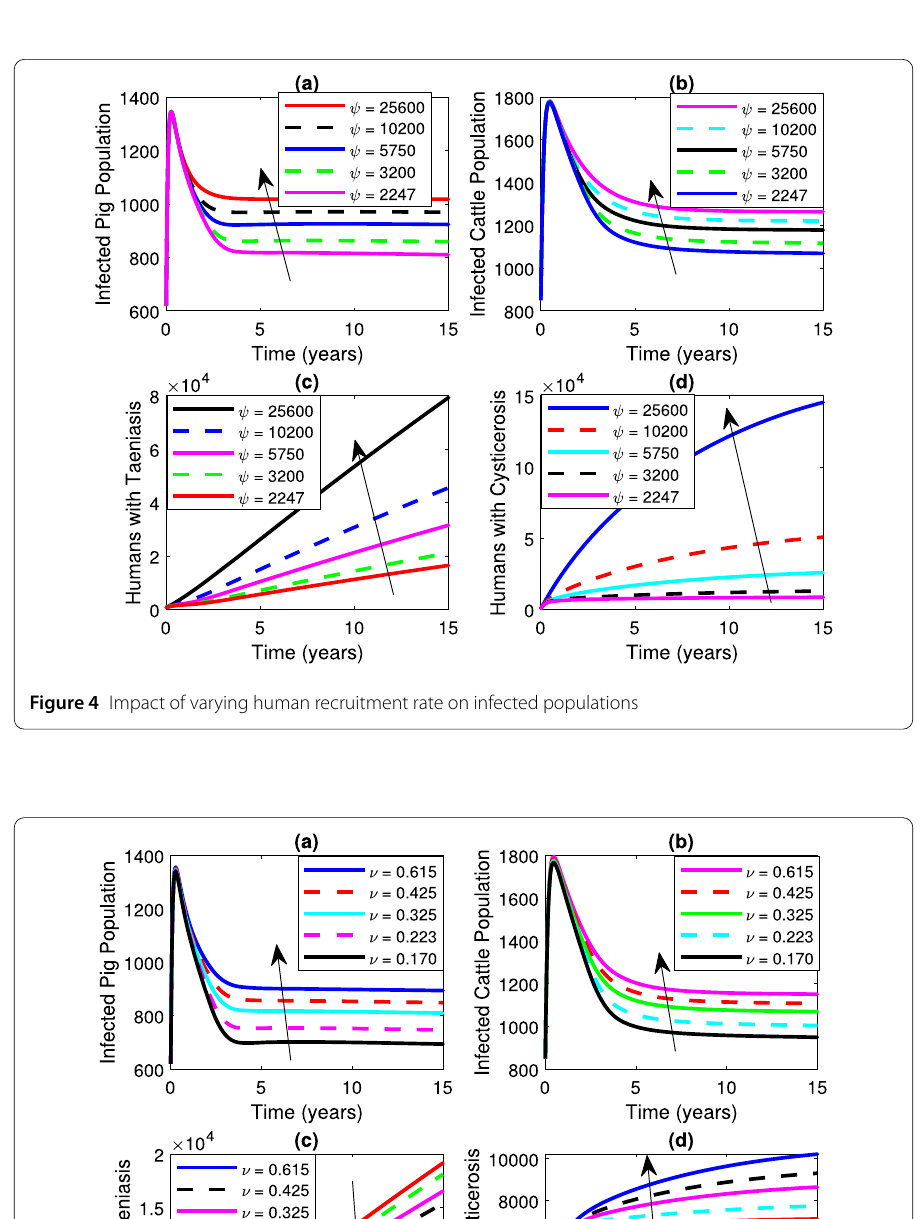
decrease in cases of humans who are infected when the human defecation rate is increased. This is due to the fact that a high defecation rate can result in an expel of a high number of taenia eggs and so the possibility of